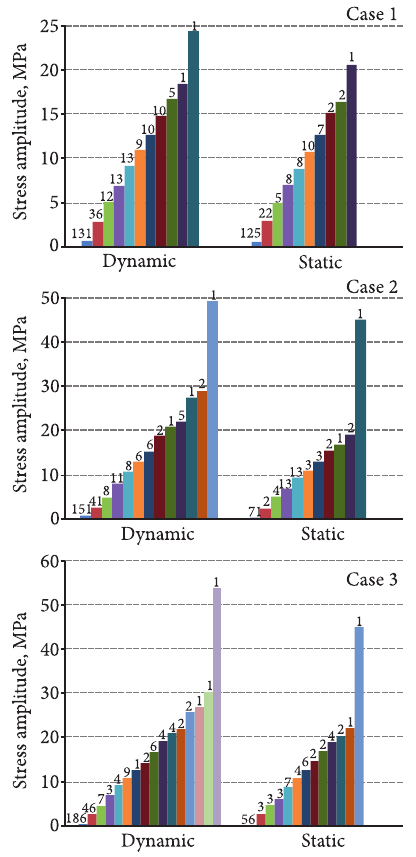
Fig. 11. Discrete stress variation counts at point C under different train load Table 6. Cumulative damage at point C under different